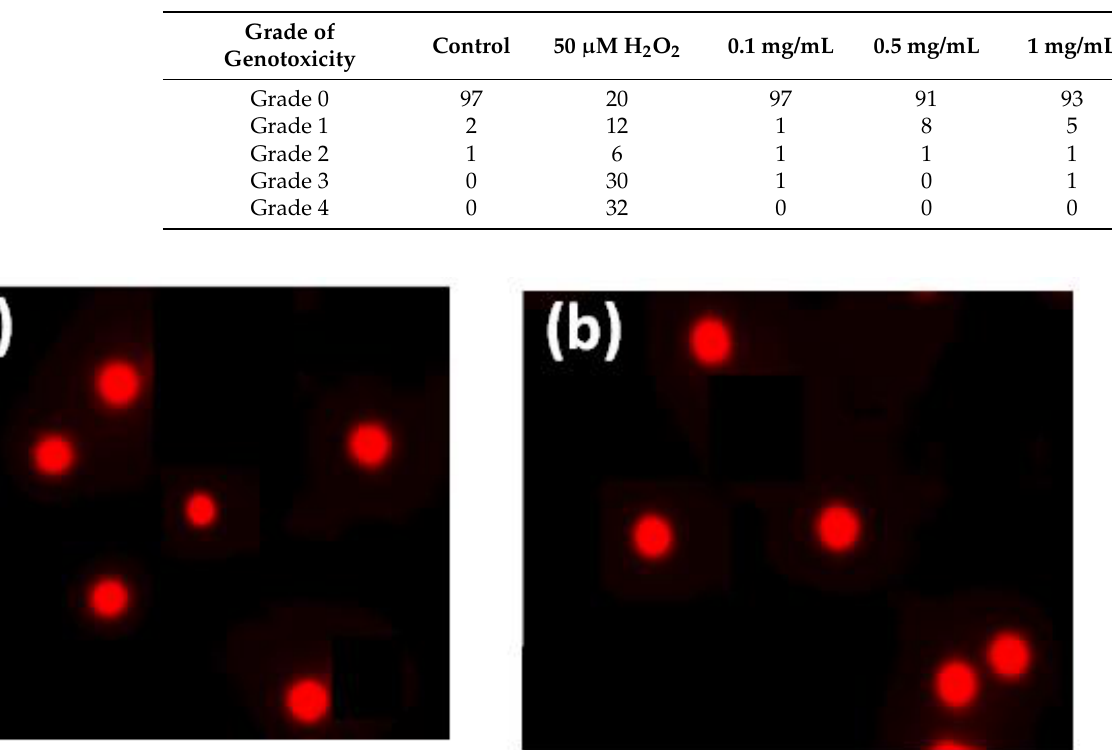
Figure 7. Comet assay images of HaCaT cell lines treated with 1 mg/mL of PEG-GMO10 formulation ( a ) and 1 mg/mL of PEG-GMO20 formulation ( b ).